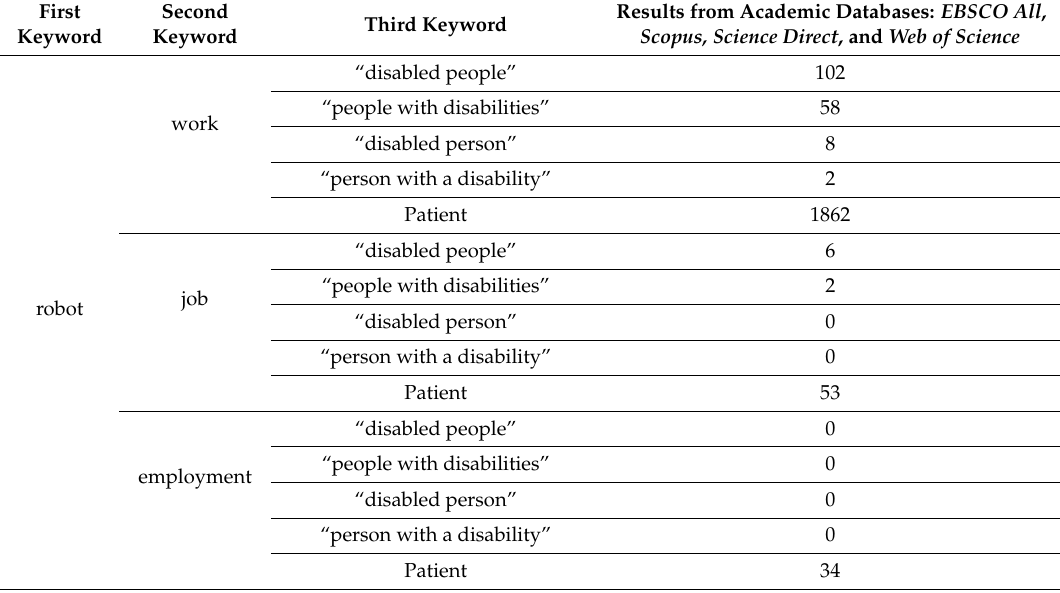
Coverage of the topic of employment of disabled people and robots within the academic